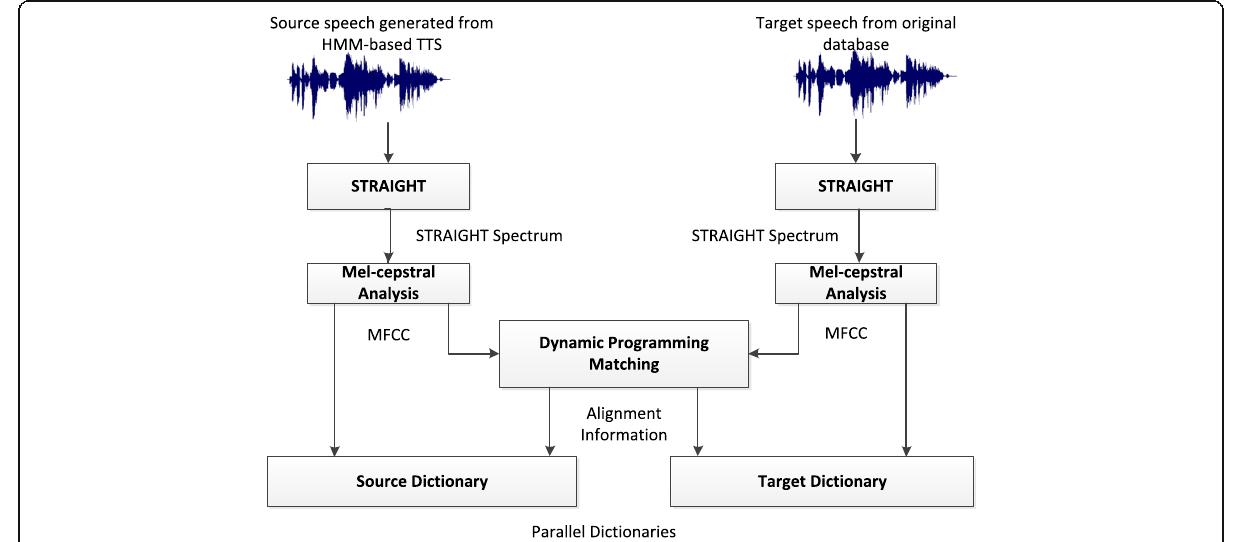
Fig. 1 Construction of source and target dictionaries for each